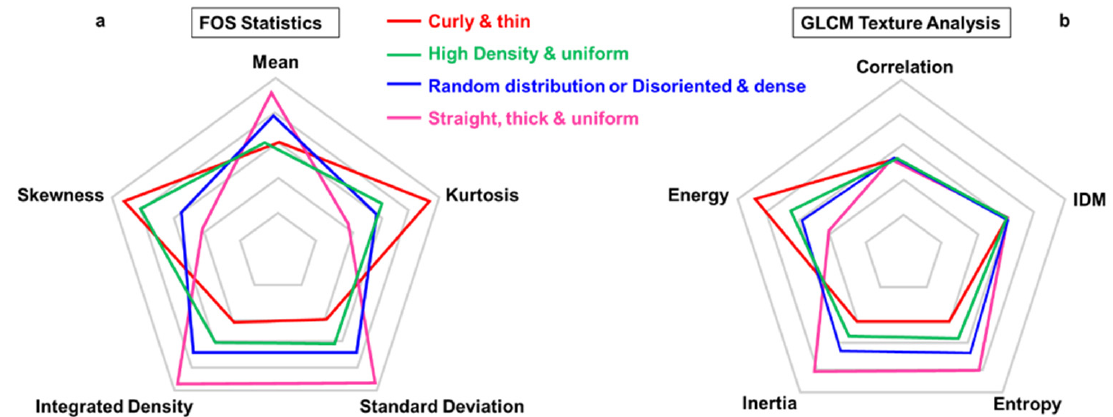
Figure 3. Radar plots for first-order statistics (FOS) and second-order statistics (gray level co-occurrence matrix, GLCM). Comparison of the statistical parameters between four categories of typical fibers arrangements: curly and thin (red), high density and uniform (green), random distribution or disoriented and dense (blue), and straight, thick, and uniform (magenta). ( a ) FOS provides the calculation of five statistical parameters: mean, kurtosis, skewness, integrated density, and standard deviation. Straight and thick fibers (magenta) are associated typically to higher values of mean, integrated density, and standard deviation. Differently, curly and thin fibers (red) are represented with higher kurtosis and skewness parameters, any intermediate situation can be shown by median values of the five FOS parameters (green and blue) [71]. ( b ) The second-order statistics (GLCM texture) is based on inter-pixel analysis, and the specific parameters are inverse difference moment (IDM), energy, inertia, entropy, and correlation. Correlation and IDM parameters do not show any significant trend according to the specific features of the tissue analyzed. On the other hand, energy shows higher values for curly and thin fibers (red), inertia and entropy are predominant for straight, thick, and uniform texture (magenta), intermediate values are represented by high density and random distribution (green and blue)